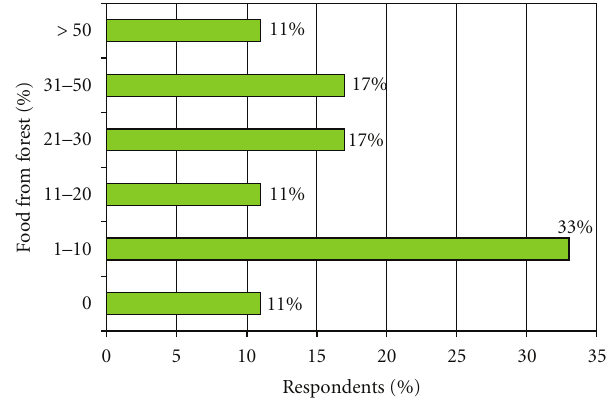
Figure 4: Food coming out from the